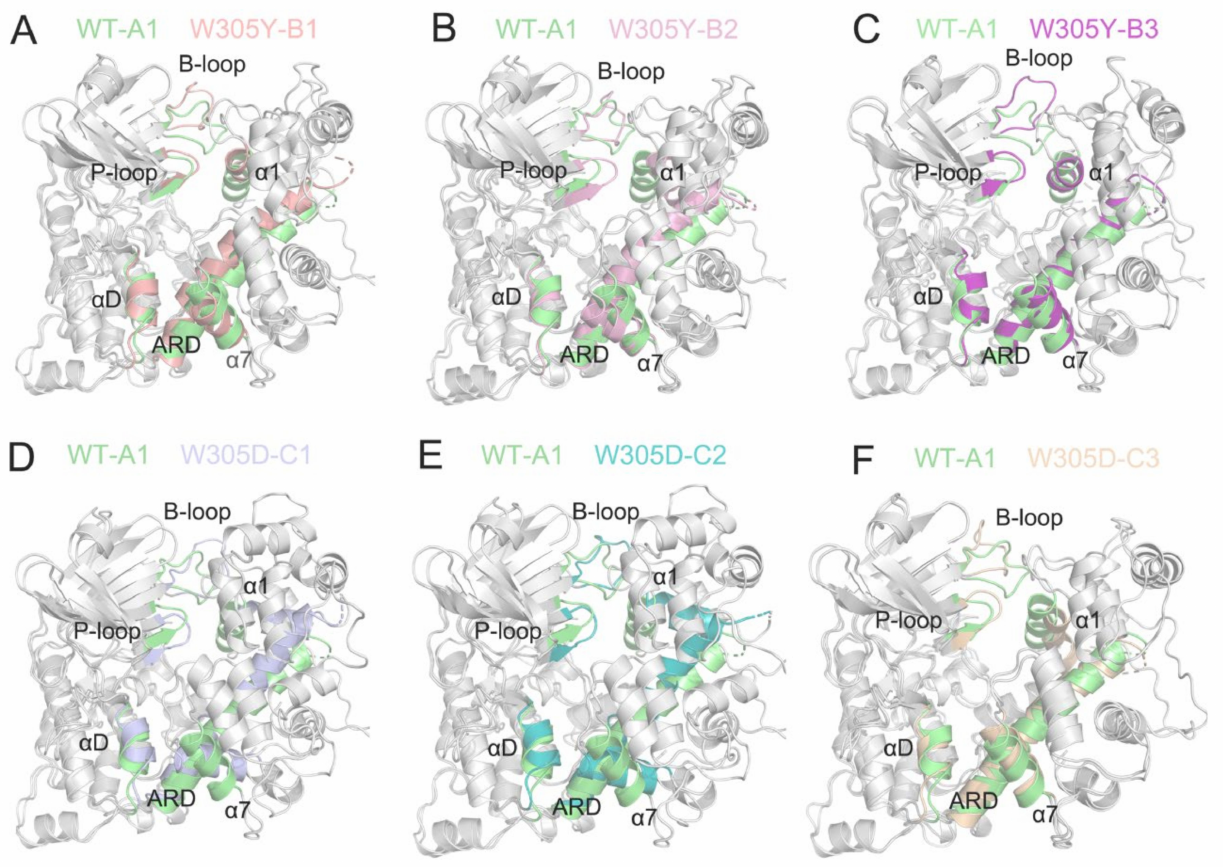
Figure 5. ( A – C ) The superimposition of the three representative structures (B1, B2, and B3) from the W305Y mutant system on the representative structure A1 from the WT system. ( D – F ). The superimposition of the three representative structures (C1, C2, and C3) from the W305D mutant system on the representative structure A1 from the WT